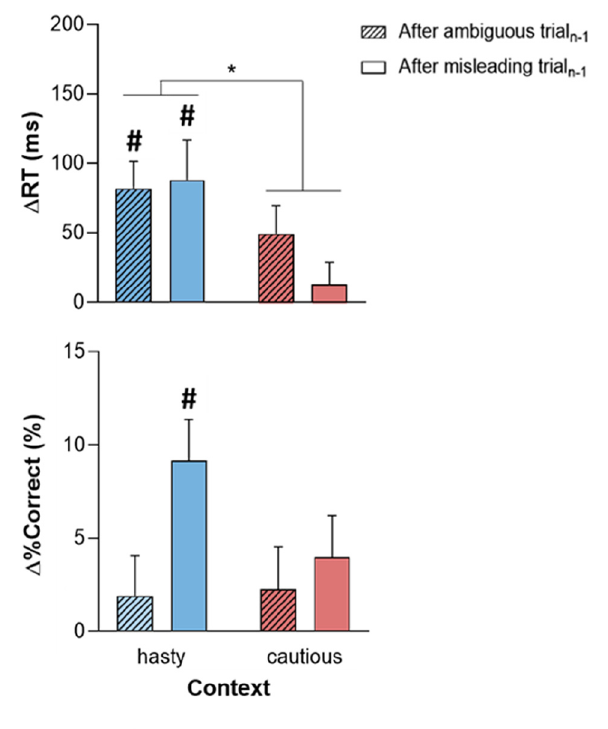
FIGURE 4 | Post-error adjustments of reaction time ( ∆ RT; upper panel) and %Correct ( ∆ %Correct; lower panel) depending on the context (hasty or cautious) and on whether trial n-1 was ambiguous (crosshatched bars) or misleading (empty bars). While the positive ∆ RT in all conditions suggests the presence of PES, this slowing down was only significant in the hasty context. The latter PES came with a positive ∆ %Correct but this effect was only significant following misleading trials n-1 . Error bars represent SE. # : t -test against 0 (significant difference from 0). * p < 0.05: significantly different.